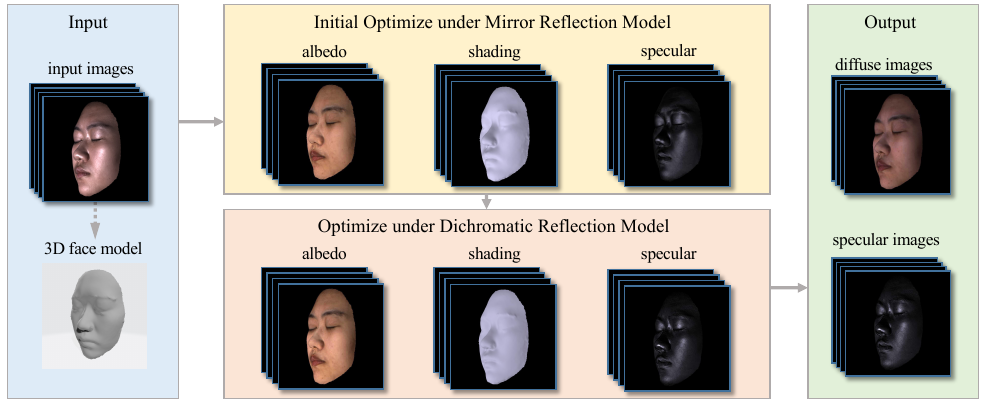
Figure 2. The schematic diagram of the proposed method. The left column shows the input multi-view images and the prior face geometry, which can be obtained roughly by input specular contaminated images as well. We first decompose the reflection components in 3D space under the Lambertian and mirror reflection models, respectively, and then render the result into 2D image space. The specular component is further pixel-wise optimized under the dichromatic reflection model in 2D image space. Parameters are estimated by minimizing the objective function using the Adam optimization algorithm [47]. The changes in the objective function determine the convergence